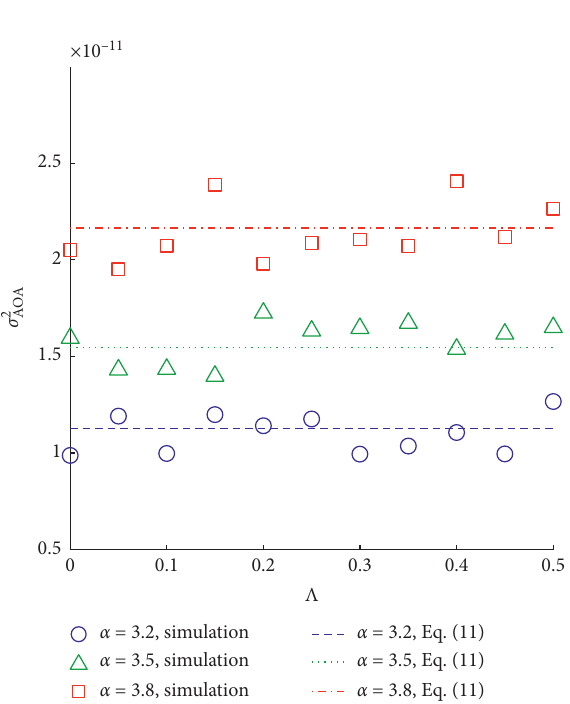
Figure 2: Validation of equation